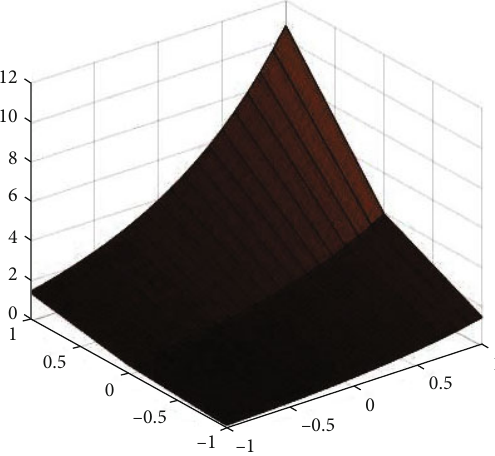
Figure 12: Analytical result of ν ð χ , ξ , I Þ at δ = 0 : 4 of